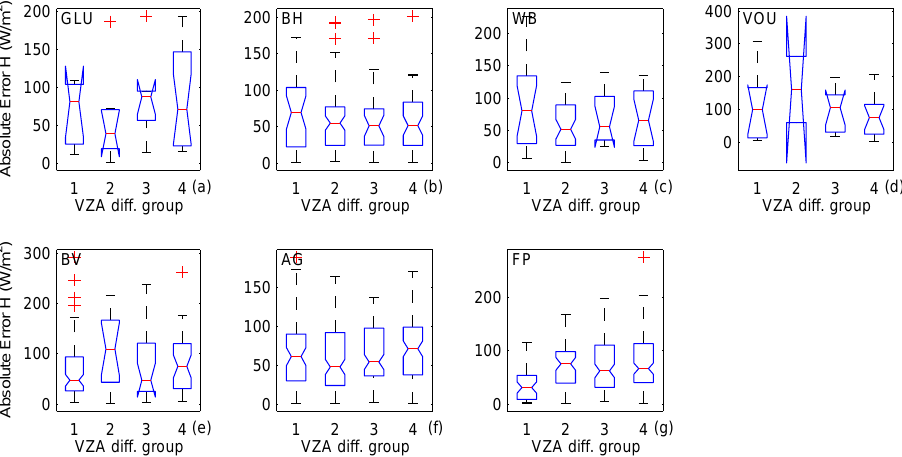
Fig. 10. Box plots of the distribution of absolute errors of the modelled sensible heat fluxes as compared to the flux tower measurements at coniferous forests (GLU, a and BH, b ), deciduous forest (WB, c ), croplands (VOU, d and BV, e ), semiarid grassland (AG, f ), and temperate grassland (FP, g ). The fluxes were grouped into four categories based on the absolute difference between the VZA of the day and night LST observations, θ dif : (1) θ dif ≤ 10, (2) 10 < θ dif ≤ 20, (3) 20 < θ dif ≤ 30, and (4) θ dif > 30. The boxes extend from the 25th to 75th percentiles with the central mark indicating the median. The whiskers extend to the farthest data point within 1.5 times the box range of the upper or lower box edges. Points beyond that are considered outliers and indicated as crosses. The notches on the boxes indicate the comparison interval: when the notches overlap there is no statistically significant difference at 5% significance level between the medians. In panels (a) and (d) the comparison interval extends beyond the box due to small number of data points.